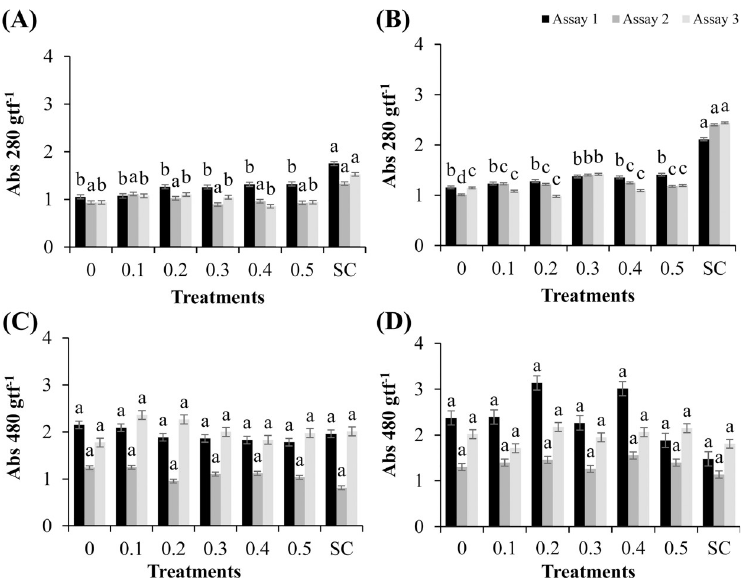
Fig 2. Synthesis of phaseolins in bean hypocotyls and deoxyanthocyanidins in sorghum mesocotyls treated with different concentrations of R . guttatus and R . marina (0.1, 0.2, 0.3, 0.4, and 0.5 mg/mL), sterile water (0), and S . cerevisiae (SC). ( A ) Bean hypocotyls treated with R . guttatus cutaneous secretions; ( B ) Bean hypocotyls treated with R . marina cutaneous secretions; ( C ) Sorghum mesocotyls treated with R . guttatus cutaneous secretions; and ( D ) Sorghum mesocotyls treated with R . marina cutaneous secretions. The experiments were performed three times for each treatment. The same letters indicate absence of significant differences by the Scott–Knott test at P � 0.05. Metric bars indicate the standard error of the mean (SE). Data were transformed as follows: ( x +1) 0.5 .